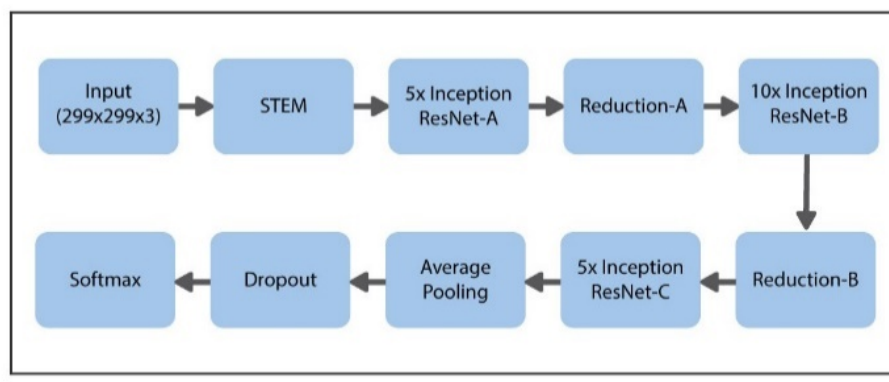
Figure 8. Proposed schema for hybrid Inception-ResNet framework.